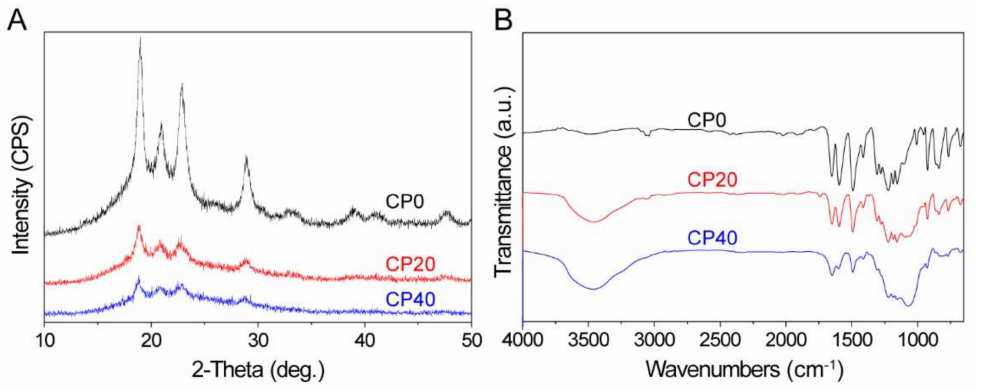
Figure 3. XRD ( A ) and FTIR ( B ) of CP0, CP20, and